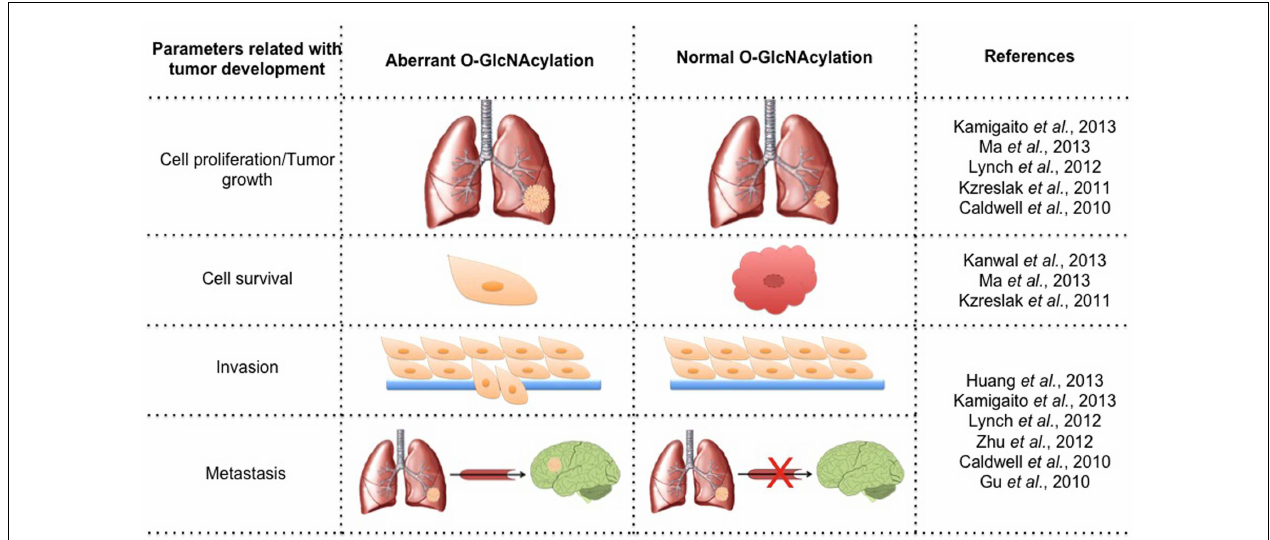
FIGURE 1 |Variation of the parameters involved in tumorigenesis by modulating the levels of O-GlcNAcylation .